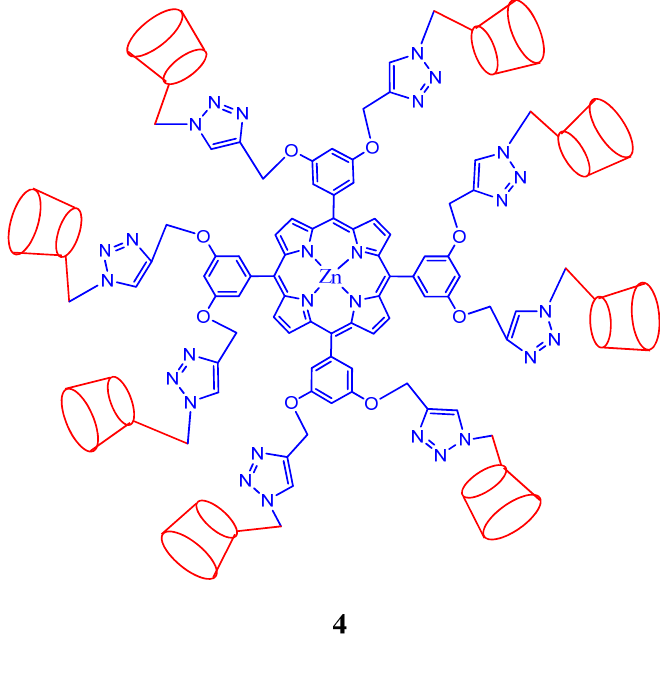
Figure 4. Schematic representation of cyclodextrin-Zinc porphyrin